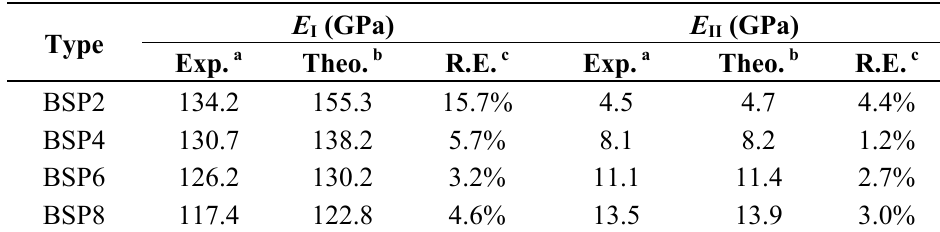
Table 3. Modulus of BSP under uniaxial tension.